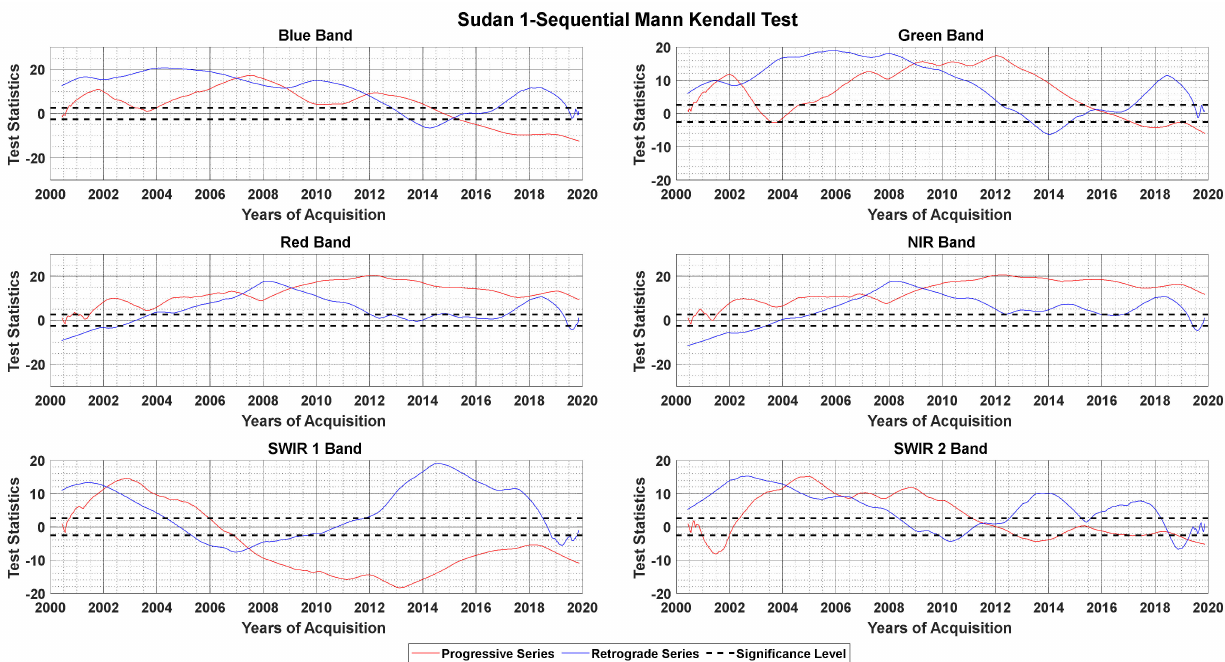
Figure 6. Abrupt change in TOA reflectance data of virtual constellation over Sudan 1 for blue, green, red, NIR, SWIR 1, and SWIR 2 bands. Table 7. Change point detection by the sequential version of the Mann–Kendall test for Sudan 1. Detected Change Points Bands